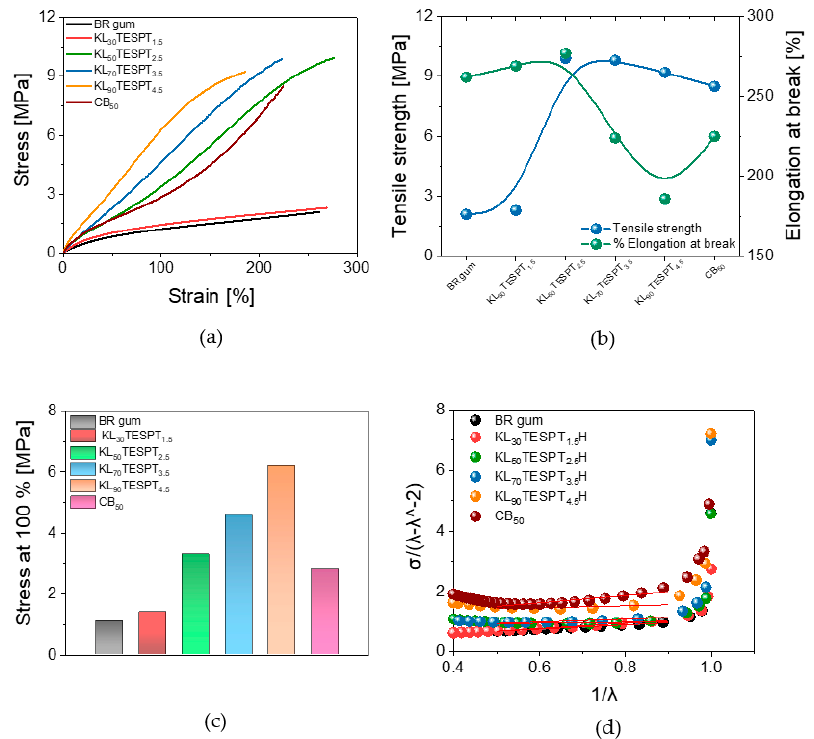
Figure 3. ( a ) Tensile stress–strain plot, ( b ) variation of tensile strength and percentage elongation at break (dot–line diagram), ( c ) variation of stress at 100% break (bar diagram), ( d ) Mooney–Rivlin plot, of all BR–lignin and BR–CB composites.